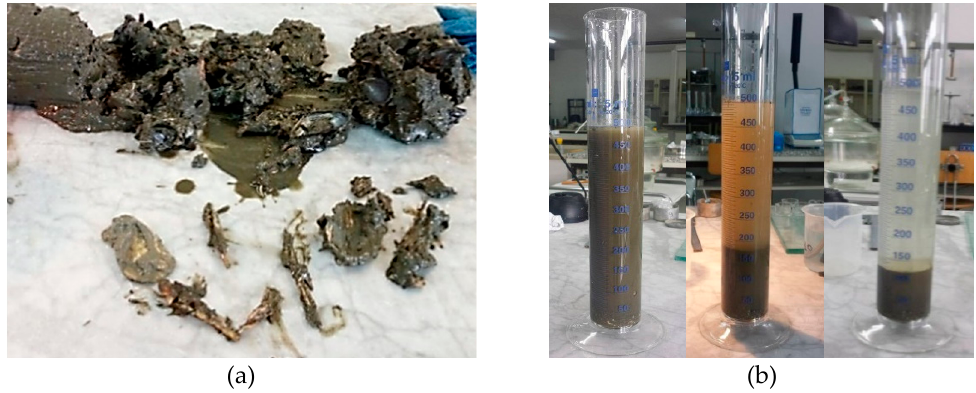
Figure 4. ( a ) Photo of a shallow sample (1 m bsf) rich in fossils and mussels. ( b ) Phases of the sediment settling process in cylinders after a step of soil washing with distilled water: start of sedimentation, 20 min later, end of sedimentation,